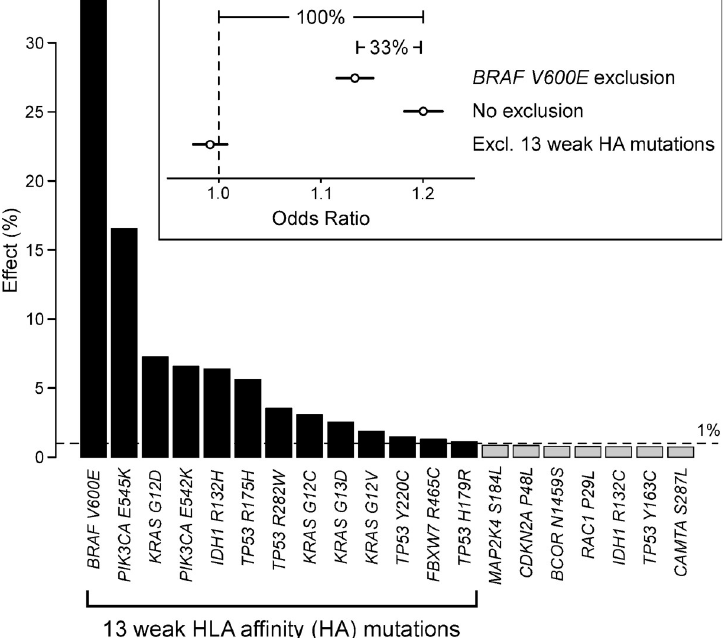
Fig 3. Identification of 13 common driver mutations with weak HLA affinity. Bar plot shows the effect size (%) of the 20 driver mutations in the dataset with the largest effect. This effect was determined by comparing a driver mutation’s odds ratio (logistic regression, within-patient model) before and after exclusion, as illustrated in the inset for BRAF V600E . Mutations with an effect size larger than 1% (dashed line, dark bars) were considered weak HLA affinity mutations. Exclusion of these 13 mutations resulted in a complete removal of any effect